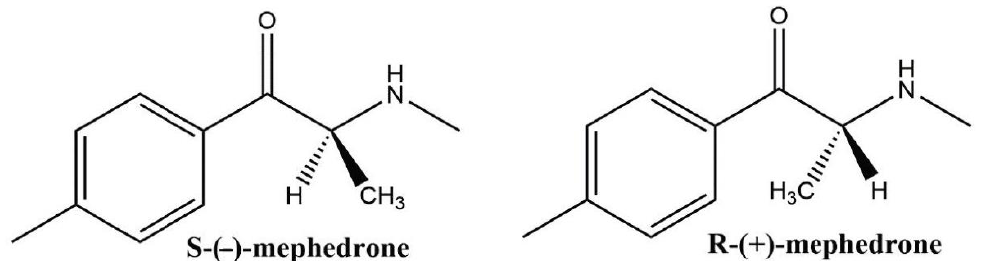
Figure 1. Chemical structure of mephedrone enantiomers.